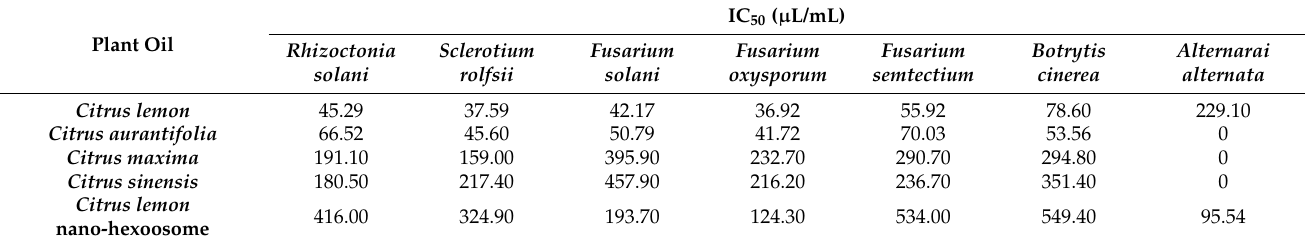
Table 2. IC 50 of Citrus essential oils and hexosomal dispersion of C. lemon against different phytopathogenic fungi.